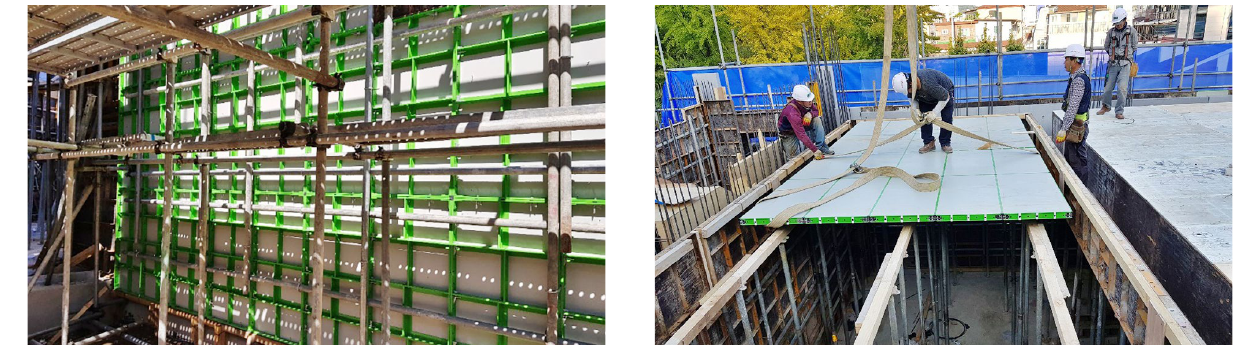
Figure 12. Field application of CSF and its table form (slab)